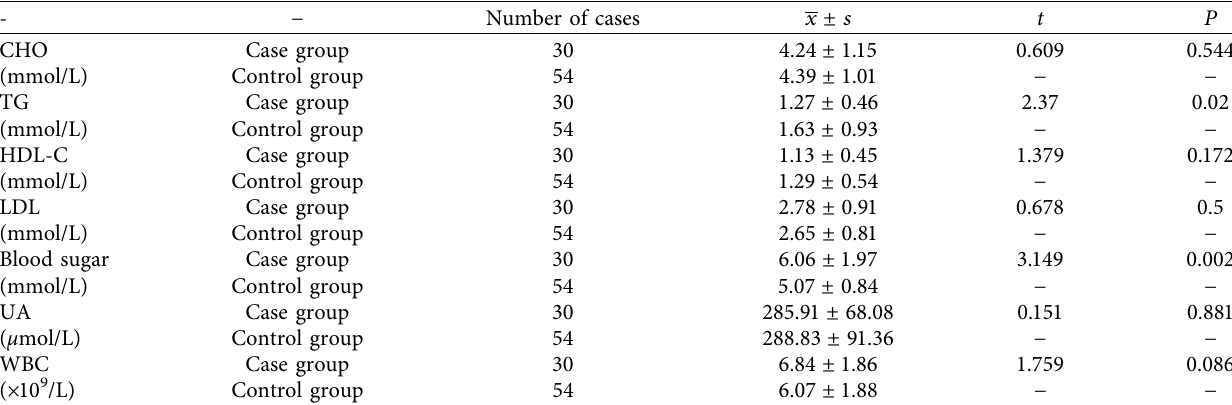
Table 2: Comparison of blood lipids, fasting glucose, uric acid, and white blood cell count between the case group and the control group.